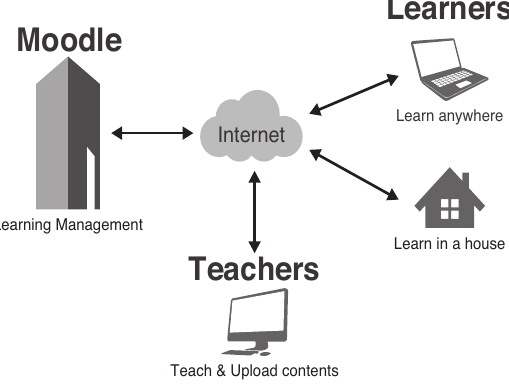
Figure 6: Systematic framework of the